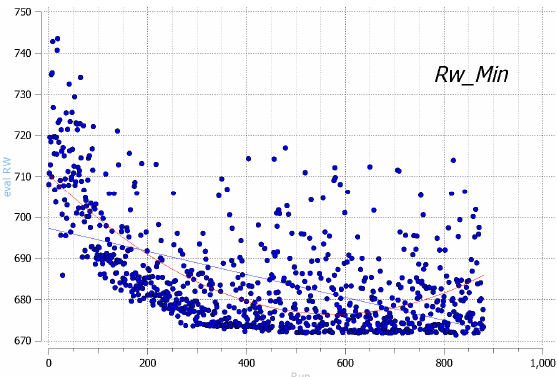
Figure 12. Convergence of the 2nd step of optimization.